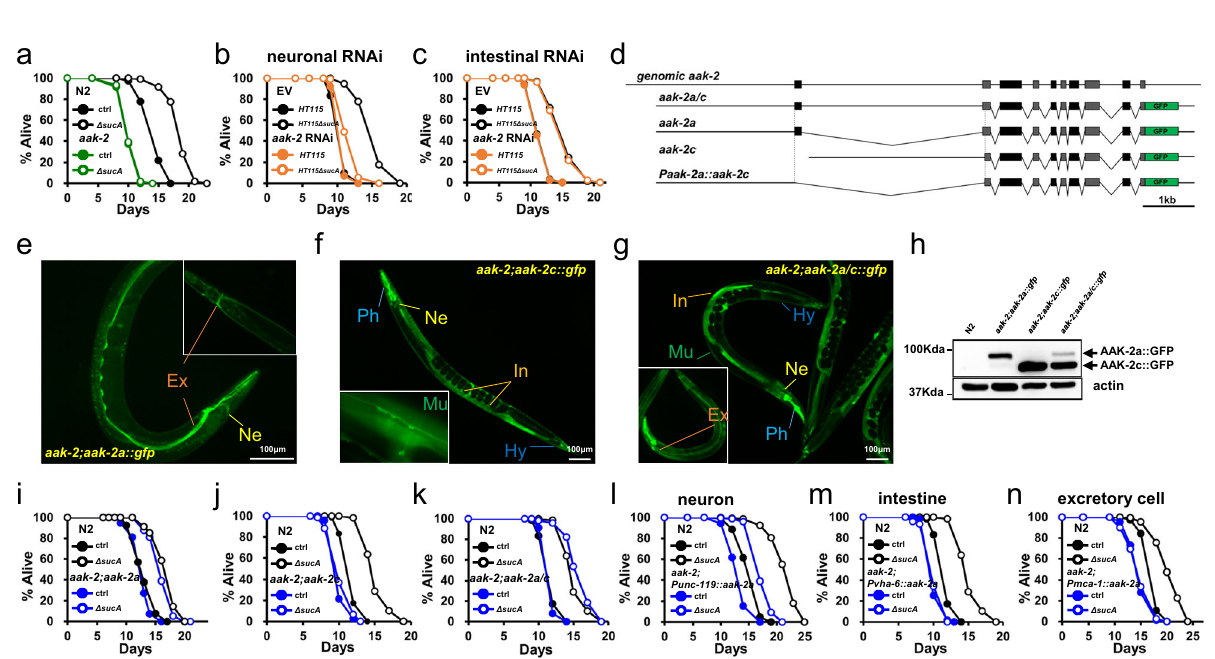
Fig. 4 | New AMPK isoform, AAK-2a modulates GR-mediated longevity in neu- rons.a Lifespanshowing that aak-2(ok524) abolishesGR-induced longevity( P =1, P value determined by two-tailed Student ’ s t test). Results from one of three biolo- gical independent experiments are shown. b , c Lifespan showing that neuronal AAK-2 is required for GR-induced longevity. Tissue-speci fi c RNAi animals are used for neuronal aak-2 RNAi knockdown ( b ) and intestinal aak-2 RNAi knockdown ( c ). Results from one of three biological independent experiments are shown. d Structure of aak-2 + gene and aak-2 isoform::gfp constructs. Coding regions are indicated as closed boxes; noncoding regions as line; introns spliced-out in DNA constructs as ∨ . Locus of start codon for AAK-2 isoforms are indicated as dotted lines. e – g GFP image showing the expression of AAK-2 isoforms. GFP images are taken using aak-2(ok524);aak-2 isoform::gfp animals. AAK-2a is expressed in the head neurons (Ne) and excretory cells (Ex) ( e ). AAK-2c is expressed in multiple tissues, including the intestine (In), pharynx (Ph), muscles (Mu), hypodermis (Hy),